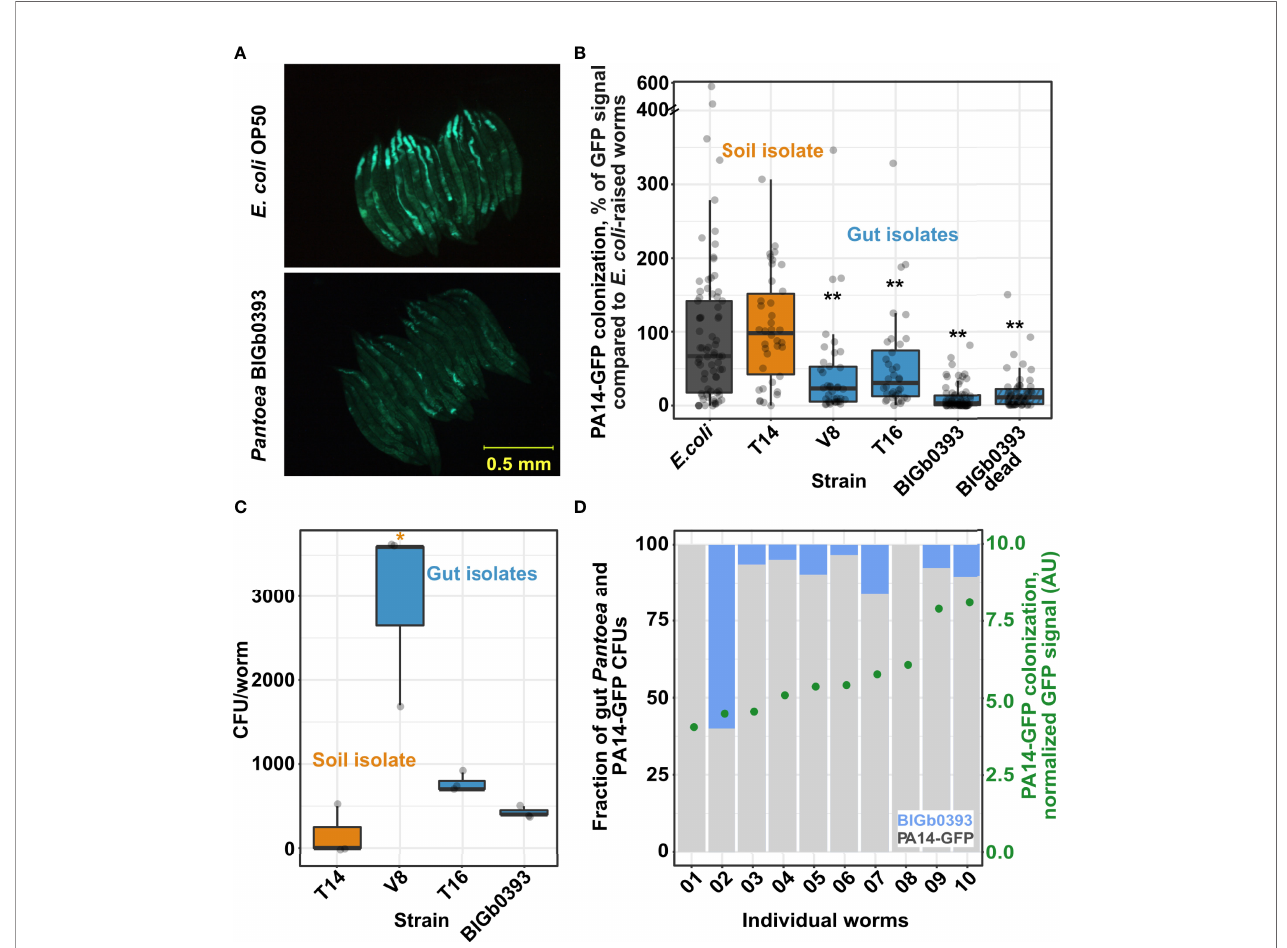
FIGURE 2 | Gut isolates but not an environmental Pantoea strain provide protection from pathogenic colonization by Pseudomonas aeruginosa PA14. (A) Worm colonization by PA14-GFP following 43-45 hours of exposure. (B) Quanti fi cation of PA14-GFP fl uorescent signal in images as in A; N=36-75 worms from two or three independent experiments. (C) Worm colonization by individual Pantoea strains. CFU counts were estimated in worms raised for 72 hours starting at the L1 stage. Shown are measurements performed in triplicate (N=10 worms each). B and (C) * and **, indicate p < 0.05 and p < 0.001, respectively (Student ’ s t-test). (D) Gut colonization in individual worms raised on BIGb0393 and shifted for 44 hours to P. aeruginosa PA14-GFP. No correlation is observed between Pantoea colonization (left y -axis, based on CFU counts), and PA14-GFP colonization [right y -axis, fl uorescent signal, arbitrary units